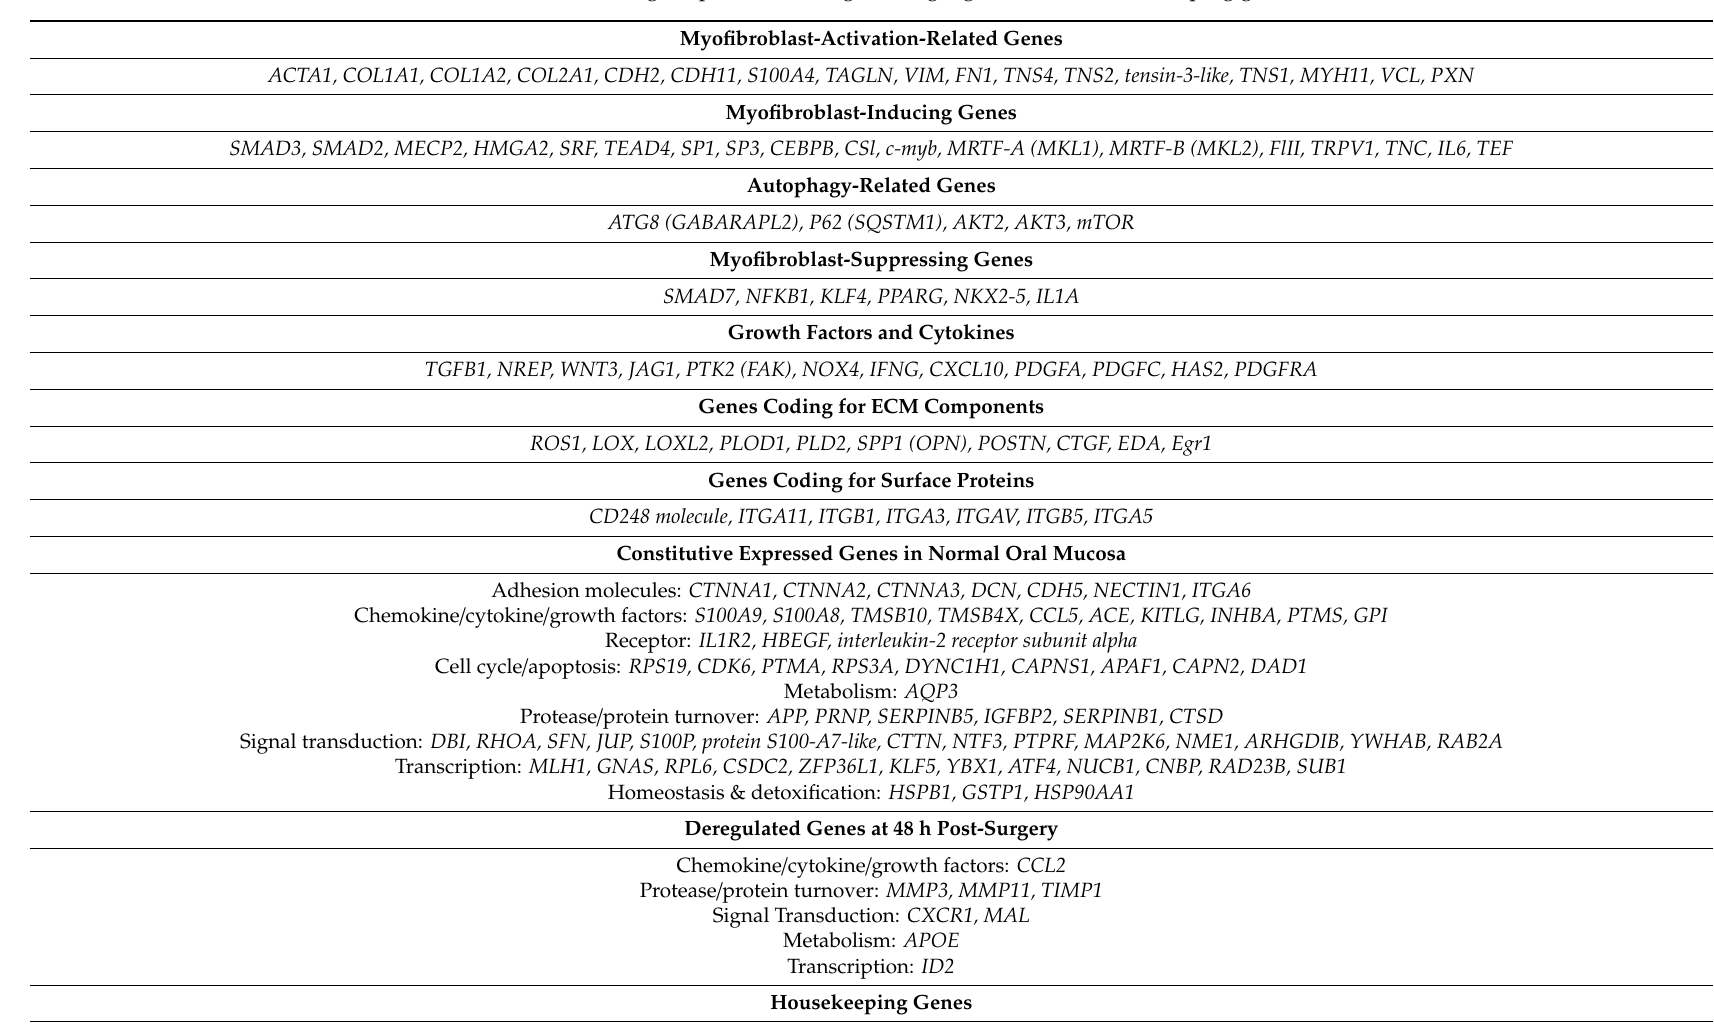
Table 1. The custom gene panel including 148 target genes and 15 housekeeping